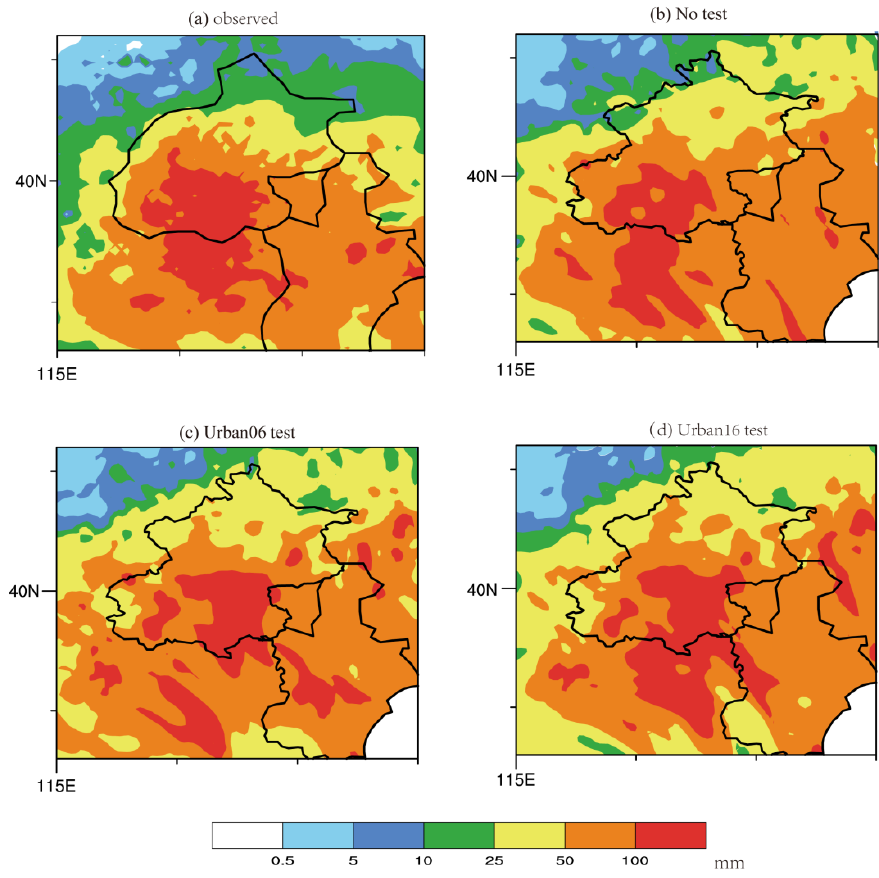
Figure 3. The observed and simulated 6 h accumulated precipitation in the heavy precipitation stage from 02:00 UTC to 08:00 UTC on 20 July 2016. ( a ) Observed; ( b ) No urban test; ( c ) Urban06 test; ( d ) Urban16 test (units: mm).